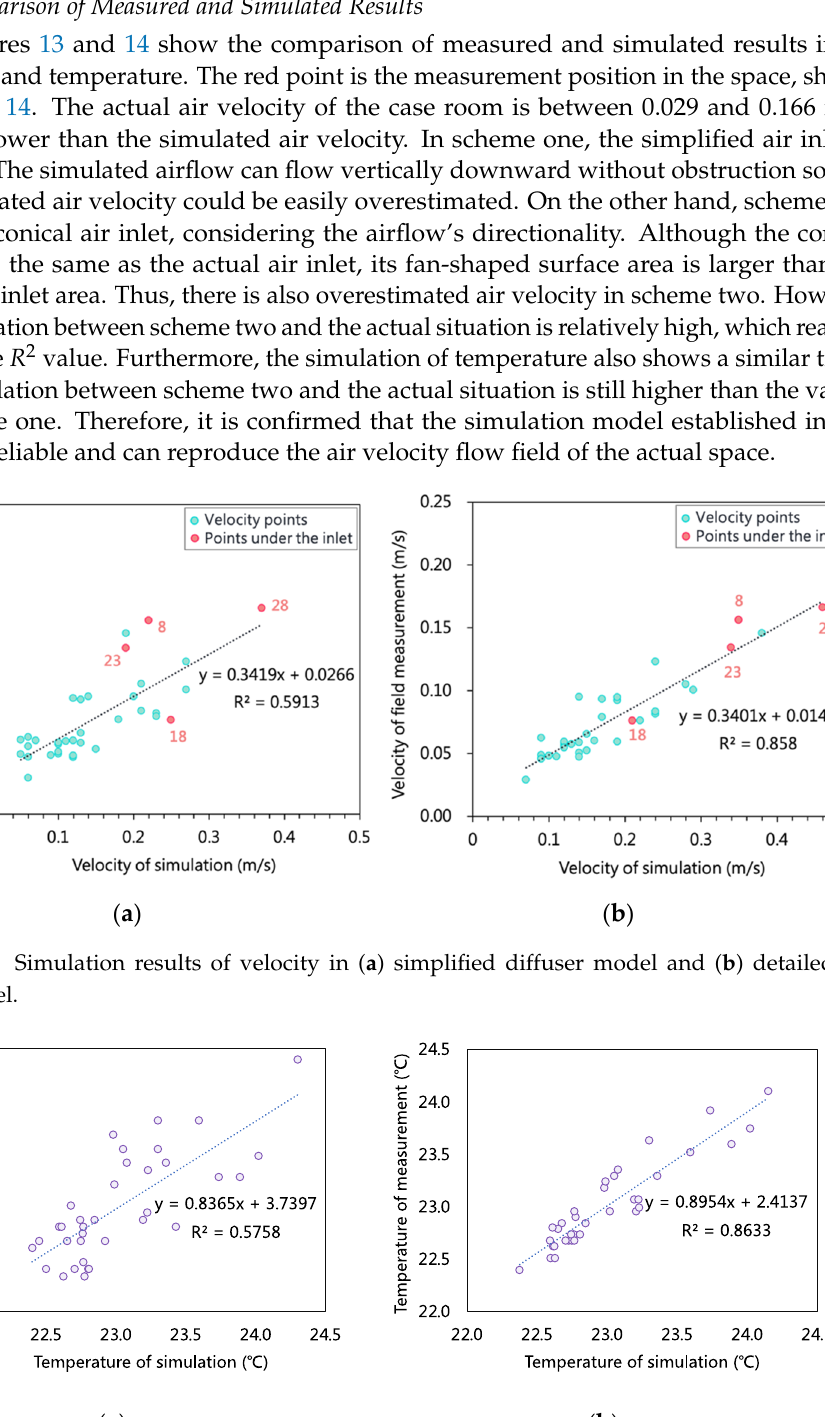
Figure 15. Air velocity distribution of scheme one and two. 3.3. Results of Building Performance Simulation in Each Case Then, the study compared the four improvement design schemes of air conditioning configuration and observed their air distribution in the simulation model. The advantages and disadvantages of each scheme were discussed based on ASHRAE and REHVA design reference standards. The simulation results are shown in Figures 16–20.